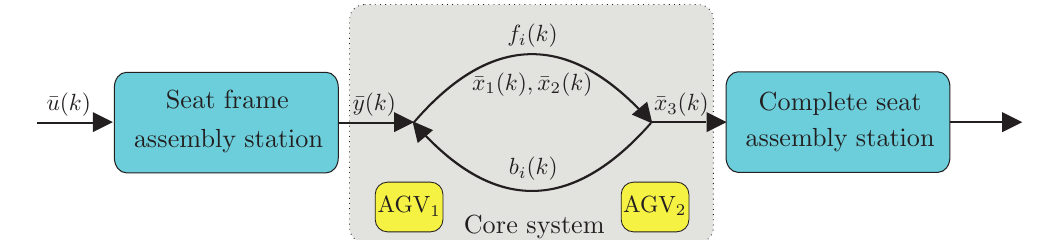
Figure 6. Sample transportation